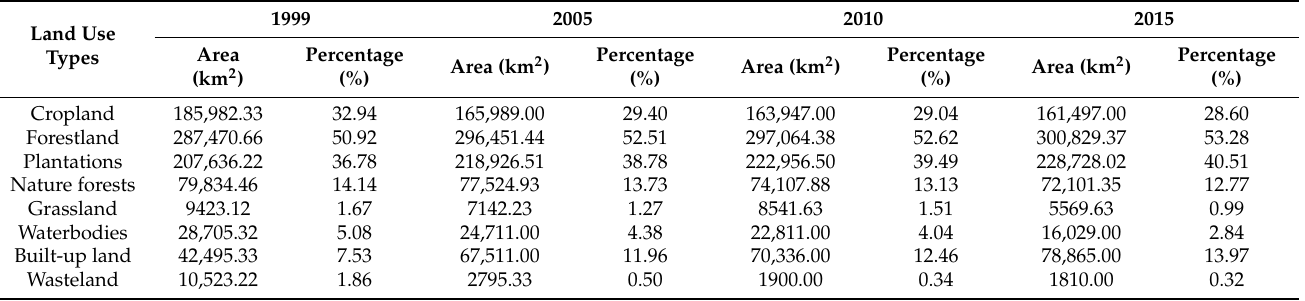
Figure 3. The Land use/cover types in the MRYR from 1999 to 2015. Table 2. Area and proportion of land use types in the MRYR from 1990 to 2015.